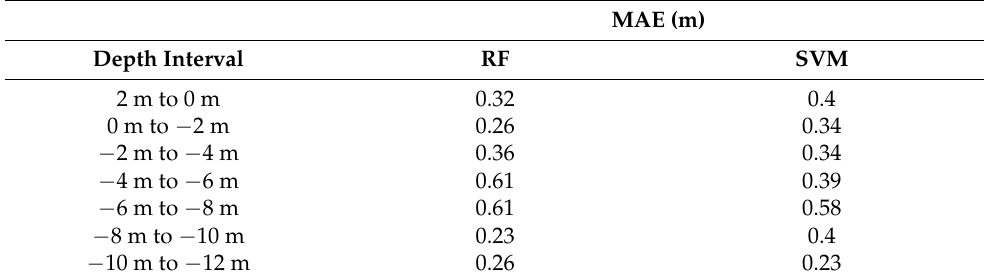
Table 4. A comparison of MAE error in the use of RF and SVM techniques.